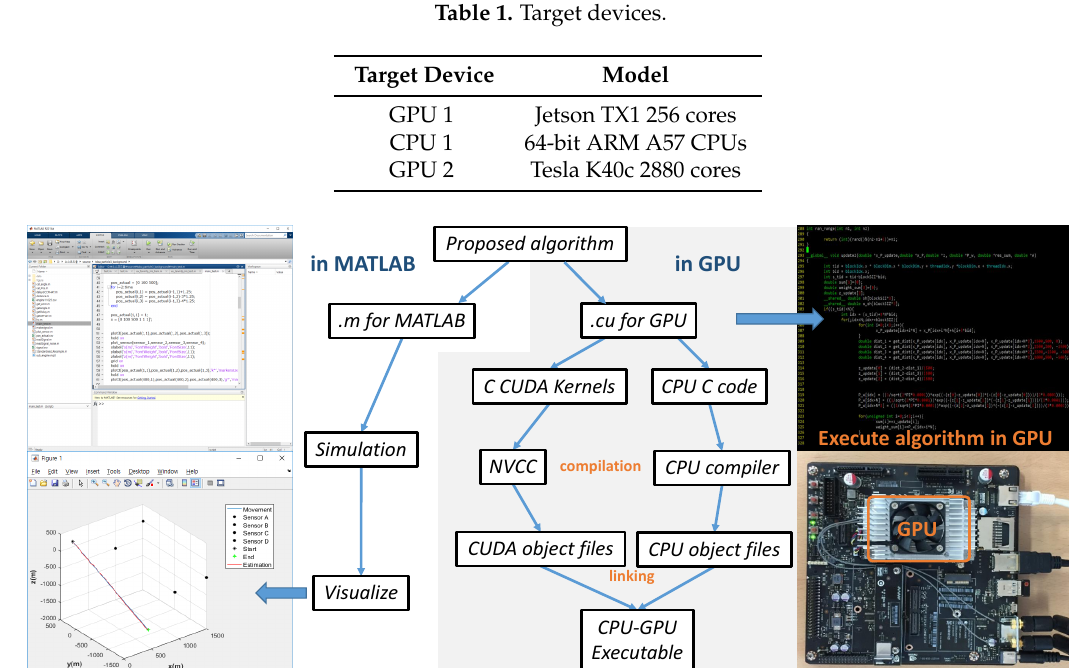
Table 1. Target devices.